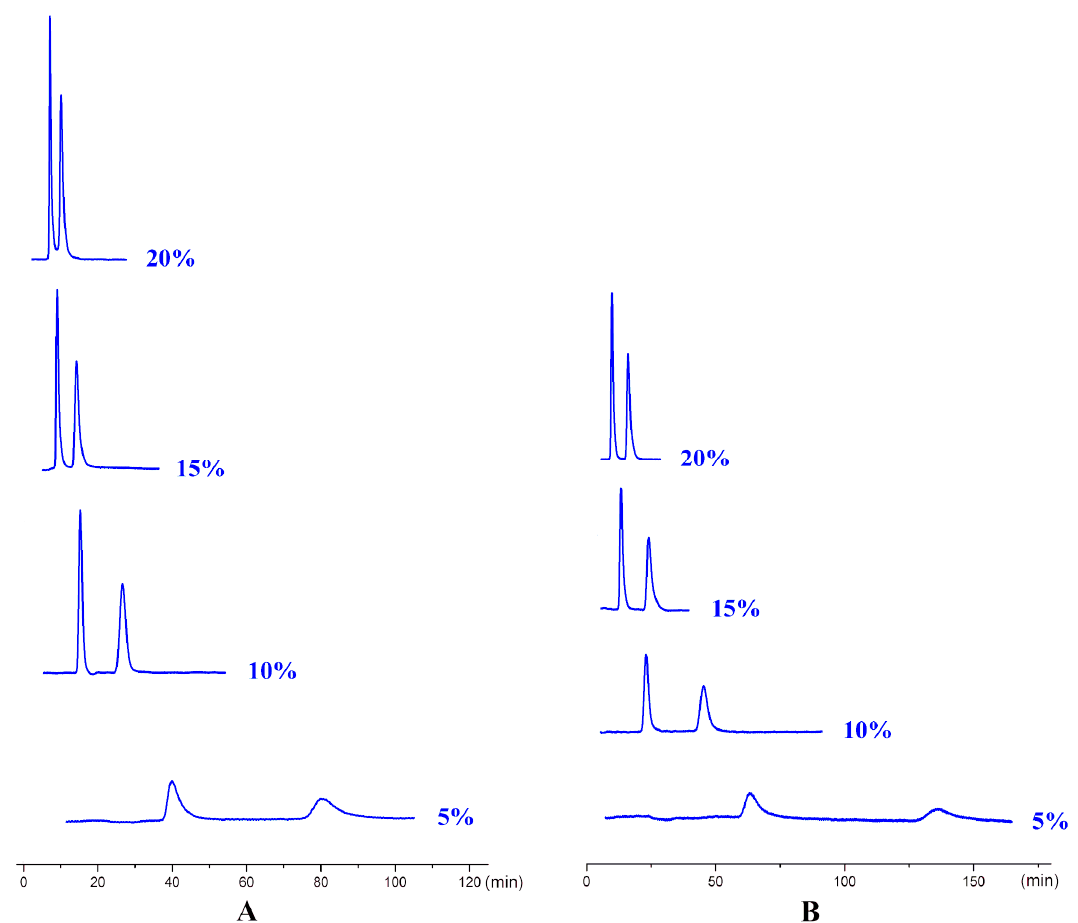
Figure 6. The influence of alcohol content on enantiomeric separation with IPA, ( A ) M2 and ( B ) MD5.